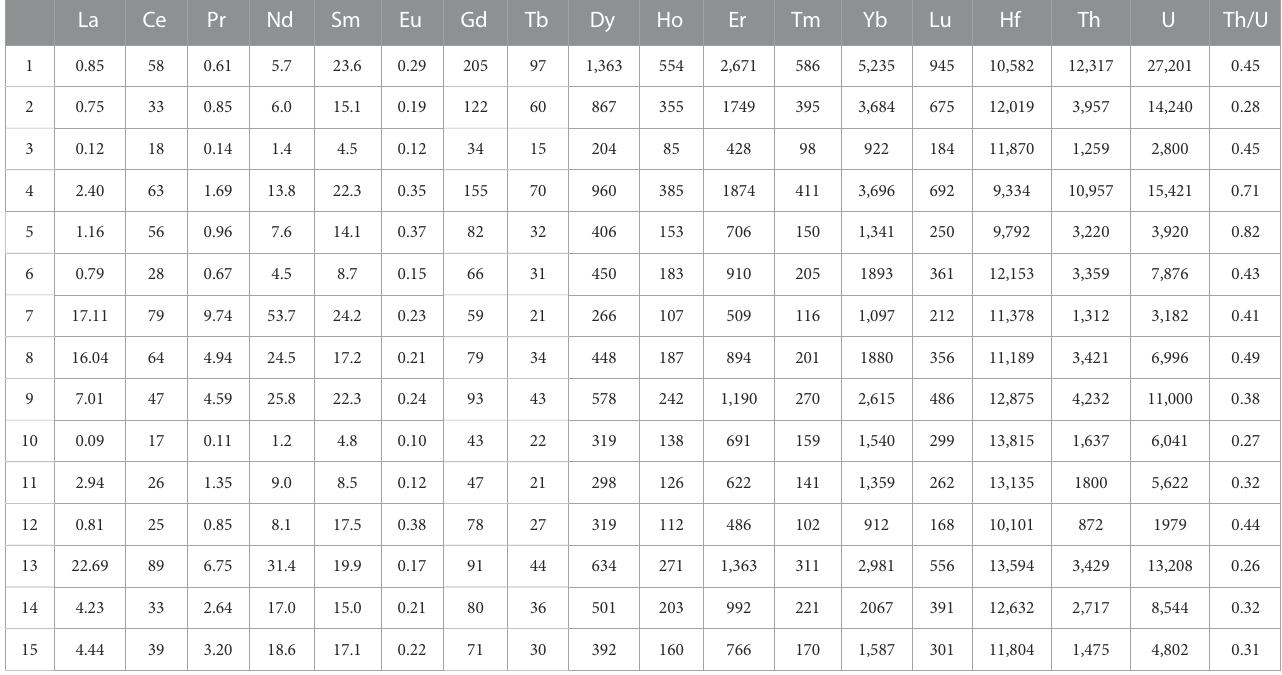
TABLE 3 Trace-element composition of the zircons from BHSG. La